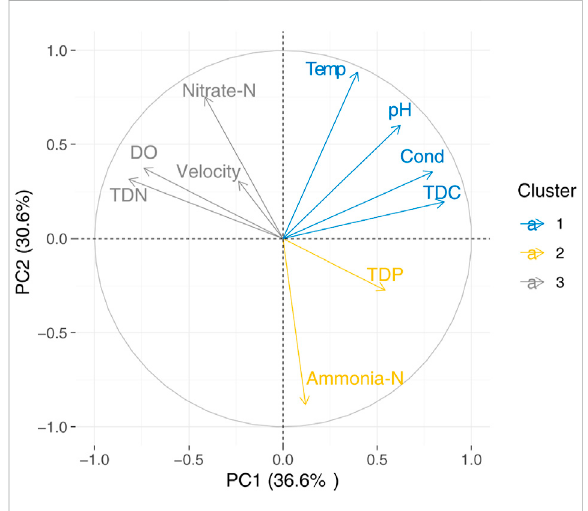
FIGURE 5 Principal component analysis of water quality parameters at woodland sites in spring, autumn, and winter. Temp and Cond are water temperature and conductivity, respectively.